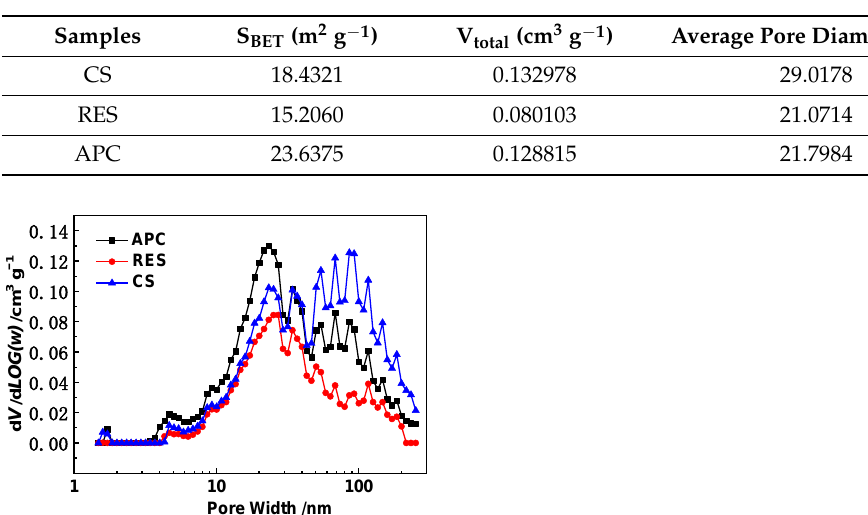
Figure 3. N 2 adsorptions isotherms of samples: ( a ) calcined carbide slag; ( b ) chicken eggshells; ( c ) AR-grade CaCO 3 . Table 3. Surface and pore structure statistics of samples measured from N 2 absorption.